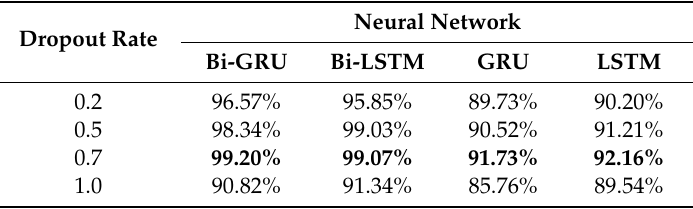
Figure 4. The comparison of di ff erent dropout rate hyperparameters for each neural network. LSTM: long short-term memory. Table 6. The results for di ff erent dropout rates in each neural network on the cross-validation data. LSTM: long short-term